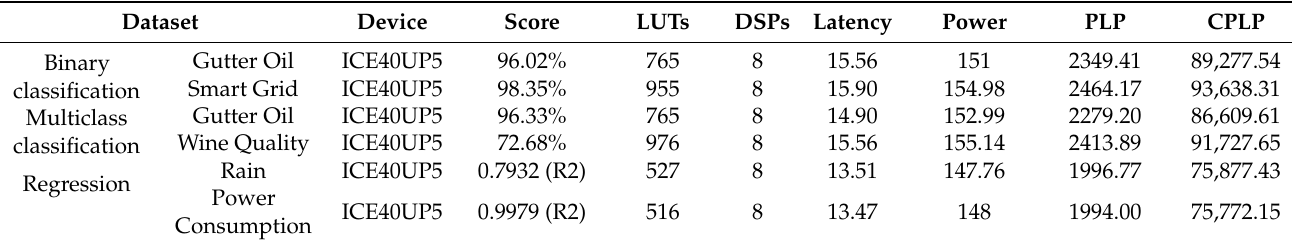
Table 14. SVM deployment results on the best CPLP-performing FPGAs.